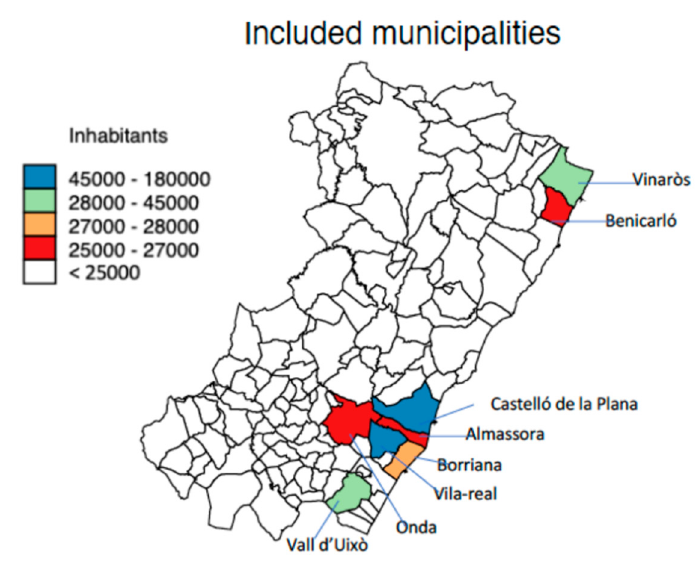
Figure 1. Geographical locations and populations of the included municipalities.